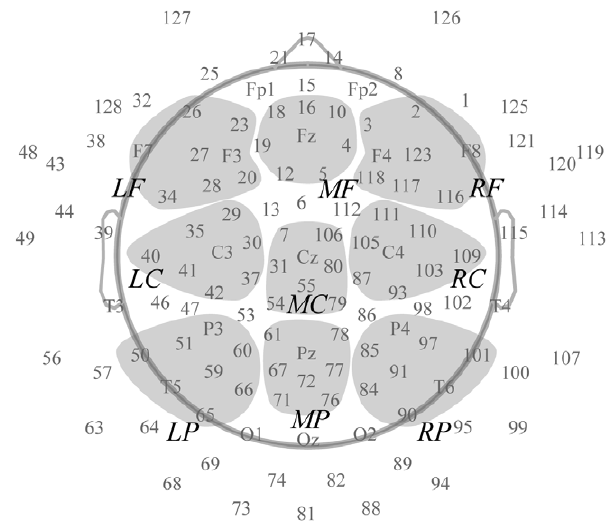
Figure 2. Schematic representation of a 128-channel montage and 9 clusters of electrodes for analysis. The 9 clusters are depicted in gray (LF, Left frontal; MF, Middle frontal; RF, Right frontal; LC, Left central; MC, Middle central; RC, Right central; LP, Left Parietal; Middle Parietal; RP, Right Parietal).